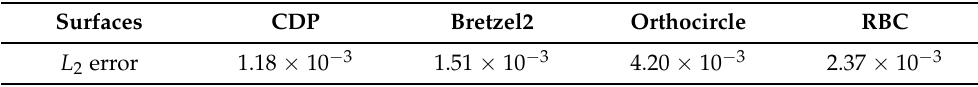
Figure 6. Example 2: Snapshots of absolute error distribution under width = 50 and depth = 4 on various surfaces: ( a ) CDP, ( b ) Bretzel2, ( c ) Orthocircle, ( d ) RBC. Table 4. Example 2: L 2 error on different surfaces under width = 50 and depth =